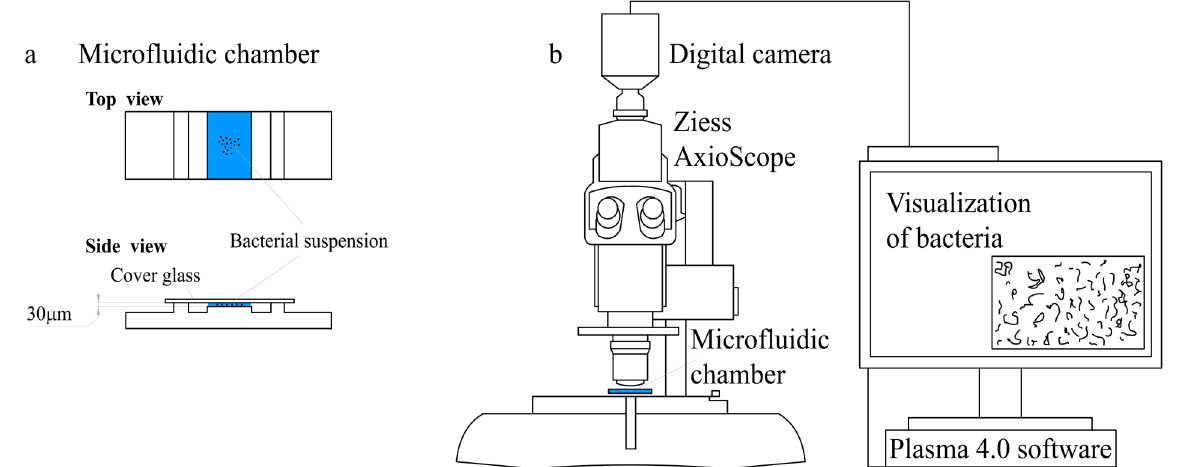
Figure 2. Scheme of ( a ) microfluidic chamber and ( b ) experimental setup.